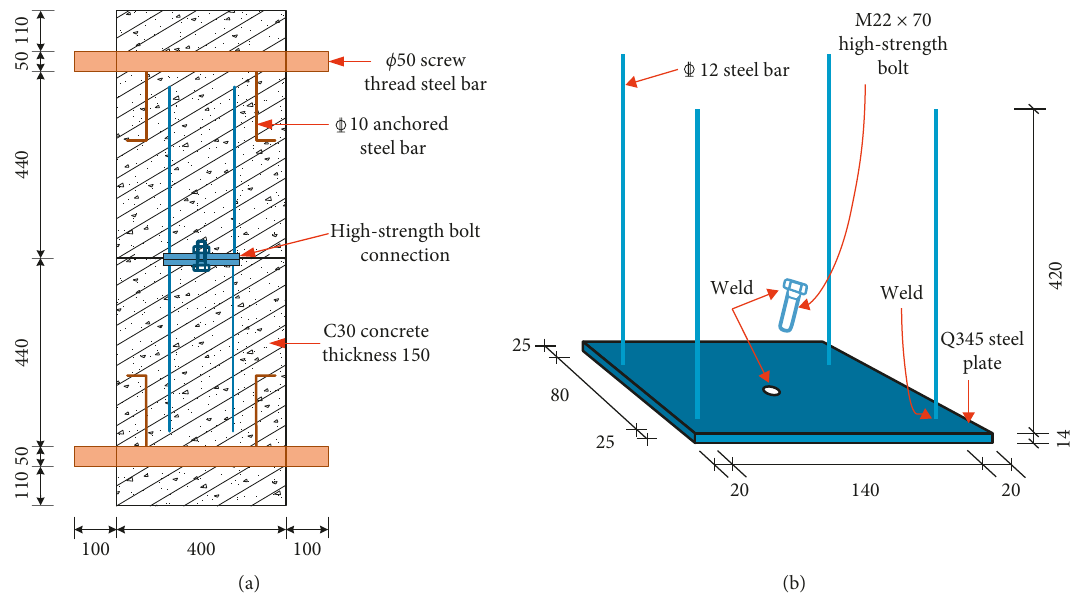
Figure 4: Configuration of the testing connection joint (unit: mm): (a) dimensions of the specimen and (b) dimensions of the embedded connection.